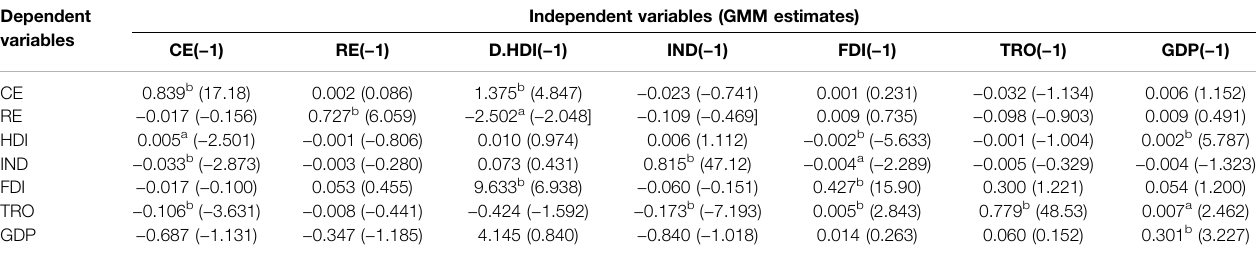
TABLE 9 | Panel VAR model estimation results for upper middle − income countries. Dependent variables